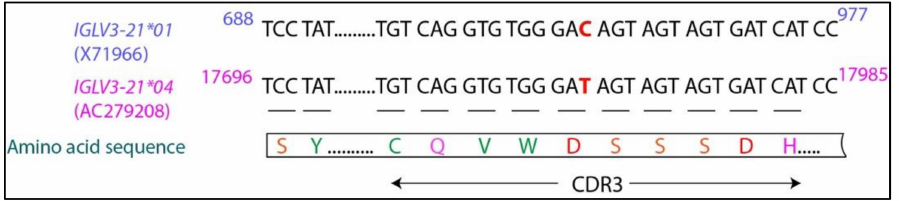
Figure 2. Sequence alignment of IGLV3-21*01 and IGLV3-21*04 alleles. The sequences were ob- tained from the IGMT database. The single nucleotide difference is marked in red. The encoded amino acid sequence as shown below the nucleotide sequences is identical for both the